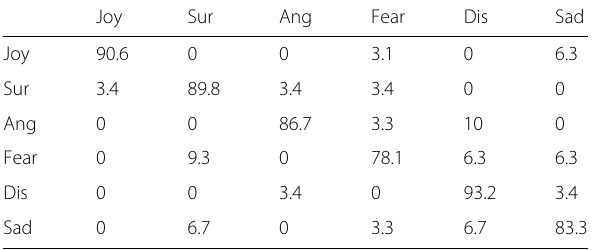
for 6-class emotion in JAFFE dataset using Improved GLTP